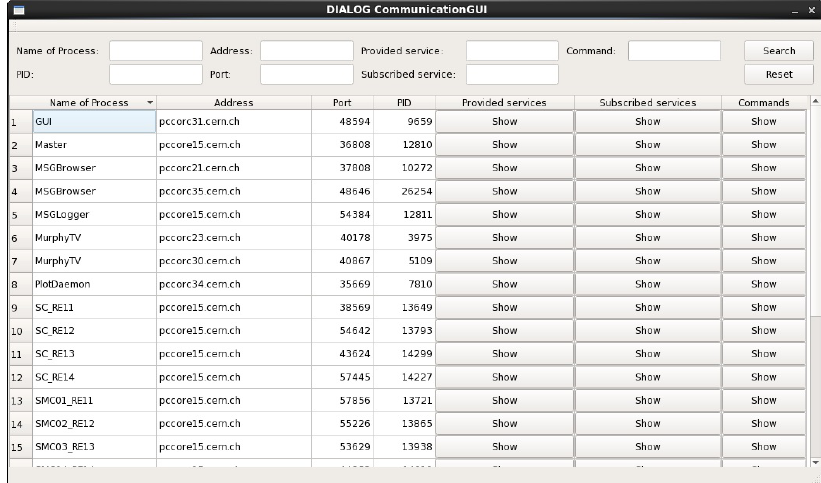
Figure 2. The DIALOG